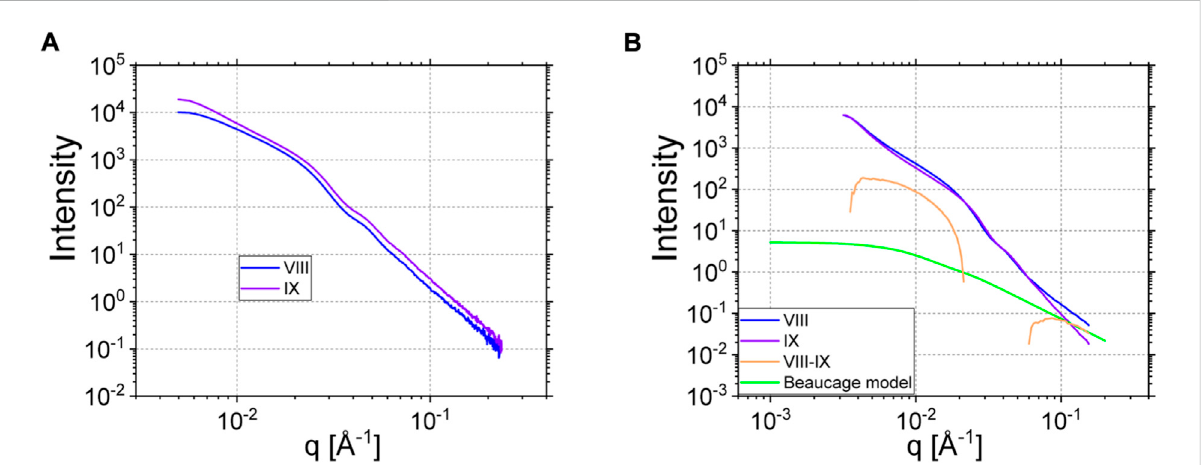
FIGURE 13 (A) SAXSdataofsampleVIIIandIX. (B) SANSdataofsampleVIIIandIX(samecolorasinA).TheorangecurveisthesubtractionofIXfromVIII.The green solid line corresponds to the Beaucage (Eq. 15) describing the excess scattering of hydrogenous polymer chains in the high q region (see text for